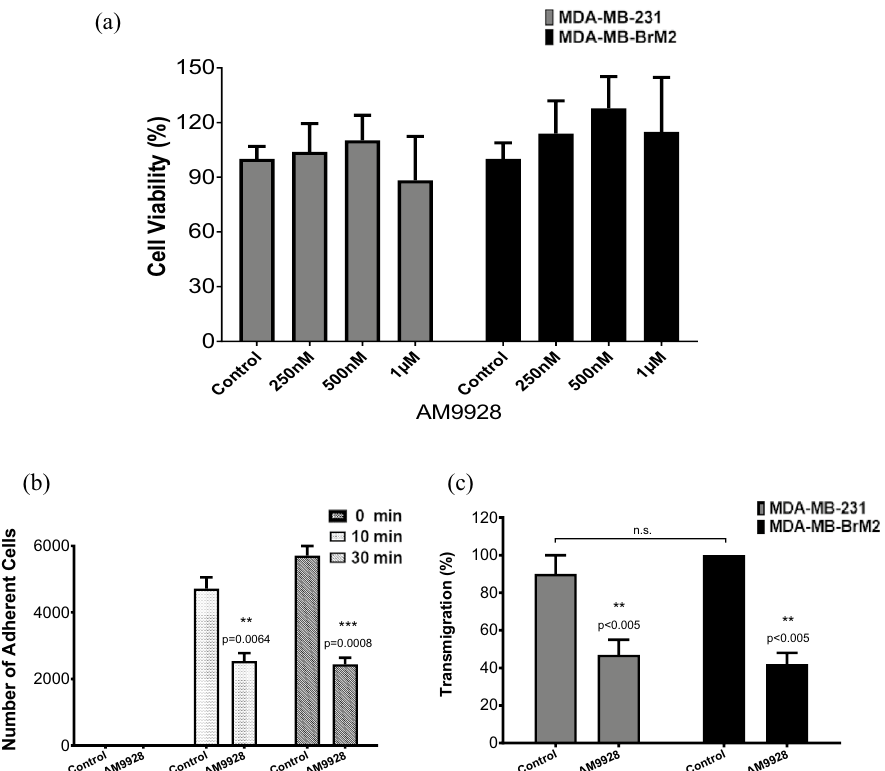
Figure 2. Effects of AM9928 on cell survival, adhesion, and trans-endothelial migration of TNBC cells across HBMEC cultures. ( a ) Effect of AM9928 on MDA-MB-231 and MDA-MB-BrM2 Cell Viability. AM9928 at different concentrations as noted (250 nM, 500 nM, or 1 μΜ) were incubated with 5 × 10 4 cells/well for 72 h and treated as detailed in the manufacturer’s protocol (Abcam Cat# ab211091, MTT assay) to determine cell viability. Absorbance was measured at OD 590 nm using Biotek reader. Error bars represents the mean ± S.D. ( b ) Adhesion: After maintaining HBMECs at confluence for 5 days, approximately 40,000 labeled MDA-MB- BrM2 cells were seeded over the monolayer in the presence or absence of AM9928 and were allowed to adhere to HBMEC monolayer for either 0, 10 min or 30 min, as indicated. The TGL (a triple-modality reporter gene of thymidine kinase (T), GFP (G), and luciferase (L)TGL-tagged cells were then counted and compared to control (untreated) cells. Data shown are representative of at least three independent assays performed on duplicate or triplicate wells. The error bars indicate standard deviations. ( c ) Transmigration: After maintaining HBMECs at confluence for 5 days, approximately 40,000 labeled MDA-MB-231 or MDA-MB-BrM2 cells were seeded over the monolayer in the presence or absence of AM9928 for 5 h. Green labeled, transmigrated cells across the HBMEC were then counted and expressed as the percentage of cells transmigrated relative to control. Data shown are representative of at least three independent assays performed on triplicate wells. The error bars indicate standard deviations. n.s not